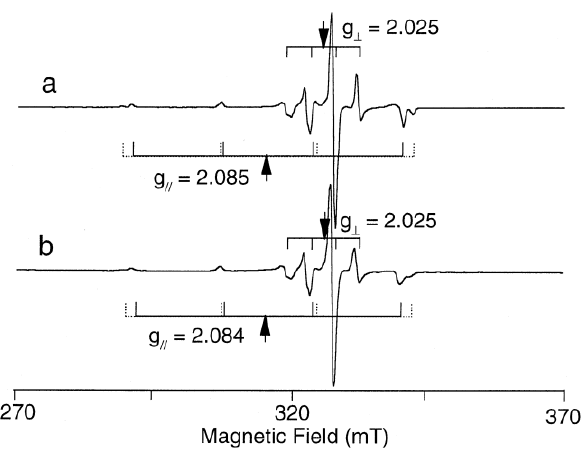
Figure 6. EPR spectrum of [Cu(S 2 CNEt 2 ) 2 ] at 77 K in ( a ) EtOH (0.05 mM) and ( b ) albumin-containing aqueous solution. Reproduced with permission from [58]. Copyright 1996 Elsevier.